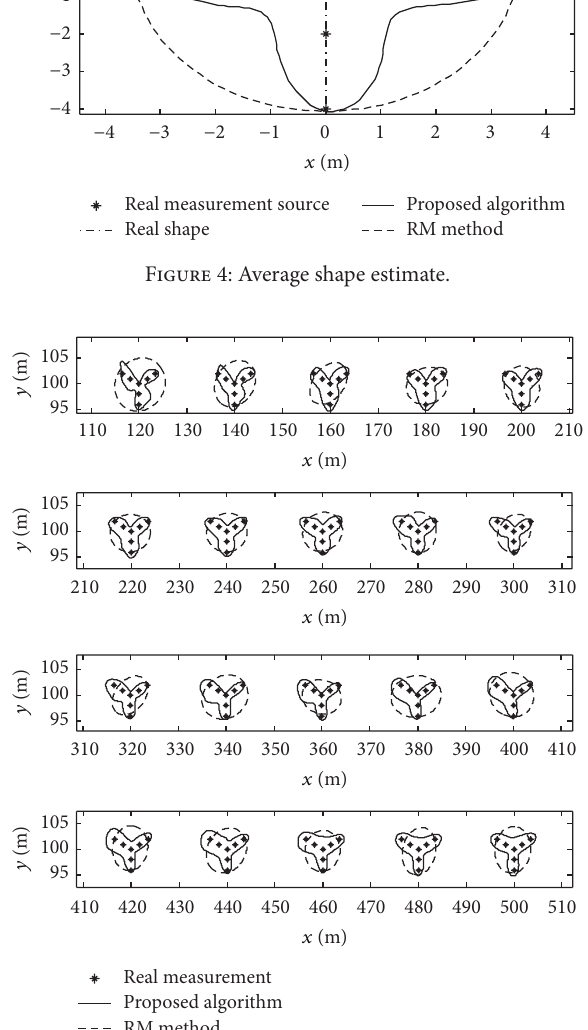
Figure 5: Shape estimation by the proposed algorithm and the RM method.